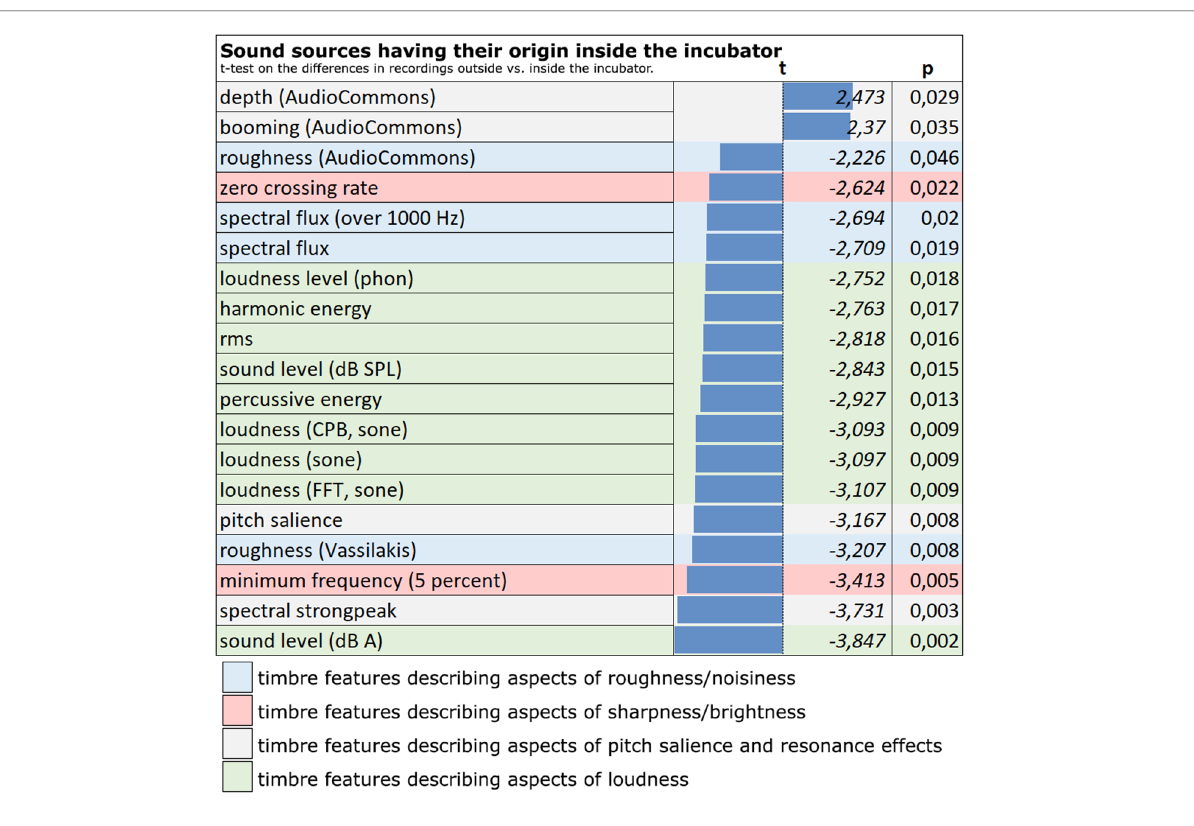
FIGURE 4 Noises from inside the incubator. Timbral differences between the recordings inside and outside of the incubator (marked red: timbre features describing aspects of sharpness/brightness; marked blue: timbre features describing aspects of roughness/noisiness, marked grey: timbre features describing aspects of pitch salience and resonance effects, marked green: timbre features describing aspects of